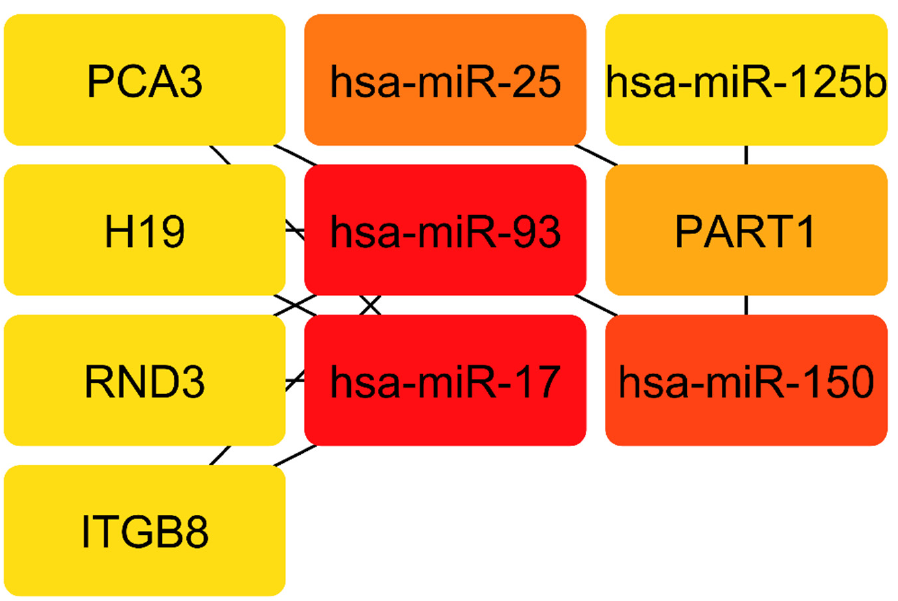
Figure 20. Top 10 genes with highest closeness centrality in ceRNA network.